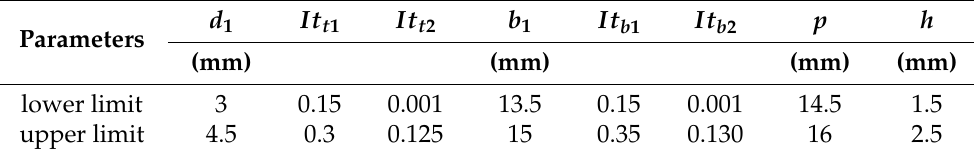
Table 2. Boundary condition of the structural